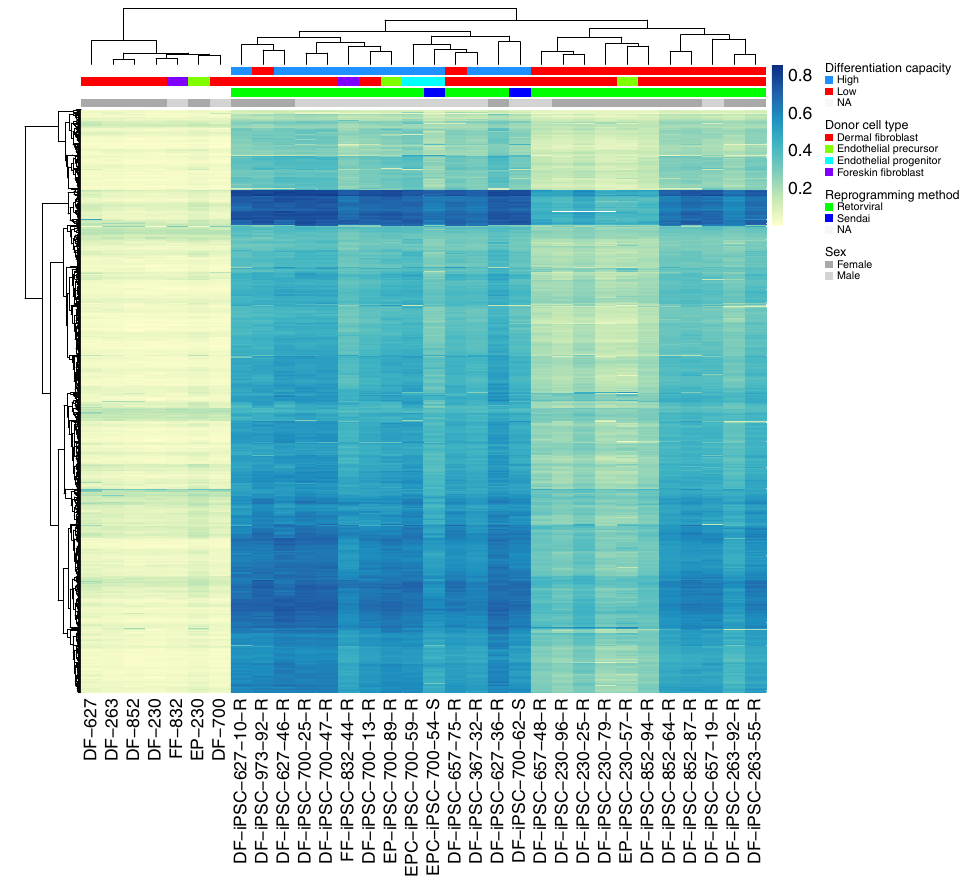
Figure 2 | Non-CG DNA methylation profiles can separate LDC from HDC hiPSCs. Unsupervised hierarchical clustering using non-CG methylation data revealed distinct separation of LDC from HDC hiPSCs, as well as from donor cell lines (top annotation bar). The heatmap shows the range of non-CG b -values for each sample and illustrates the tendency towards hypermethylation in HDC hiPSCs compared with that in LDC hiPSCs; donor cell lines are characterized by distinctly unmethylated non-CG